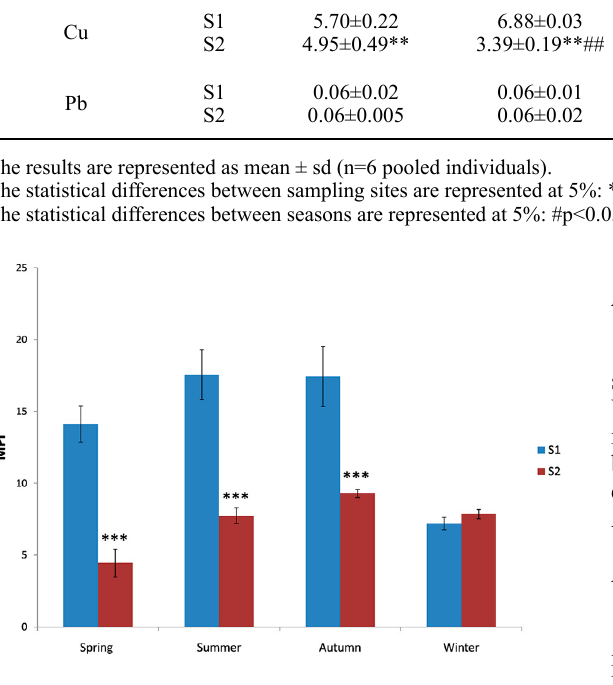
Fig.2. – Seasonal variation of the metal pollution index (MPI) in P. cultrifera tissues collected from the port of Rades (S1) and the Punic port of Carthage (S2). (The results are represented as mean ± sd [n=6]). The statistical differences between sampling sites are represented at 5%: *p<0.05; **p<0.01 and ***p<0.001 using one-way ANOVA. The statistical differences between seasons are represented at 5%: #p<0.05; ##p<0.01 and ###p<0.001 using one-way